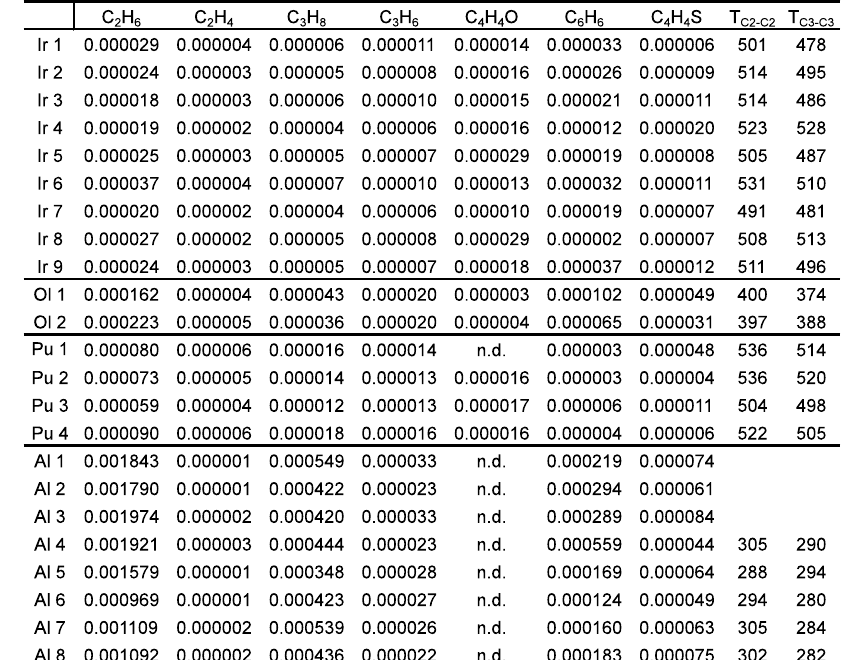
Table 2. Chemical compositions (dry gas fractions) of light hydrocarbons (C Irruputuncu (Ir), Olca (Ol), Putana (Pu) and Alitar (Al) volcanoes. Concentrations of gas compounds are in mmol/mol; n.a.: not analyzed; n.d.: not detected; n.c.: not calculated.